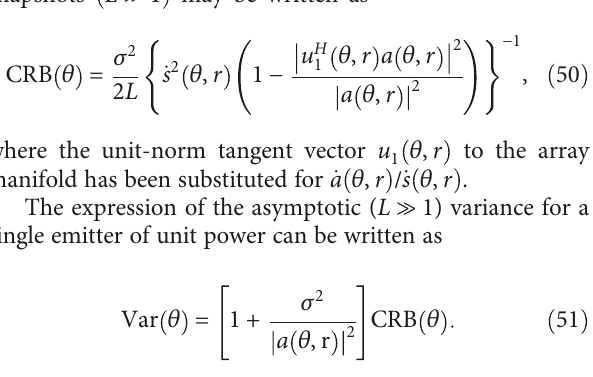
Figure 7: Theoretical CRB with respect to the change of